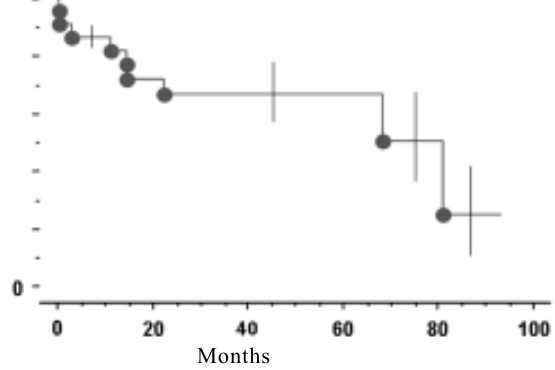
Fig. 1 – Actuarial freedom from reoperation in congenital mitral stenosis according to the